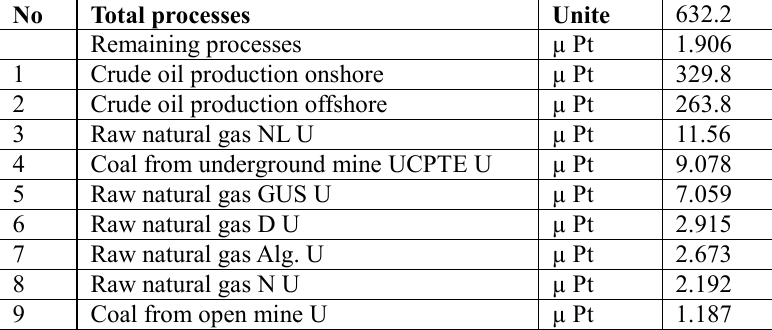
Fossil fuel sub processes weighting